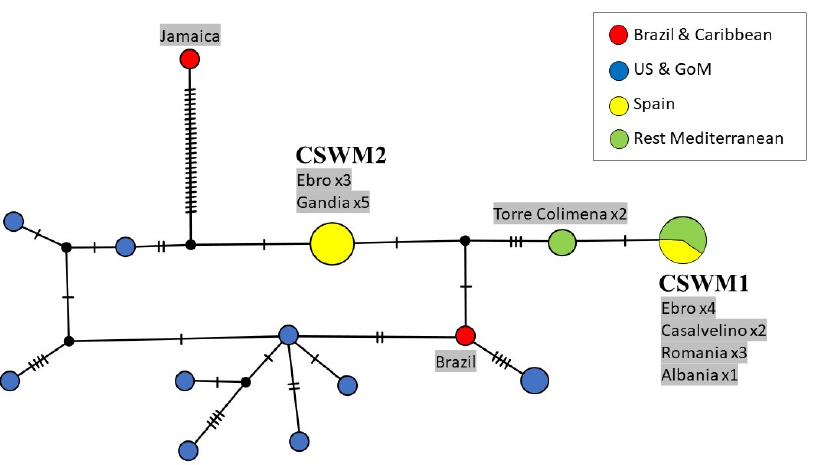
Figure 4. Maximum parsimony network showing genetic distances among 32 sequences of Callinectes sapidus combining the ‘Folmer region’ and beginning of the ‘Palumbi region’ of the COI gene (998 bp; 22 current study, 10 GenBank), constructed with TCS (Popart vers. 1.7). Diameters of the circles correspond to the frequencies of the respective haplotypes. The numbers of dashes display mutational steps (each dash stands for one single nucleotide mutation). Small black circles represent hypothetical (missing) haplotypes. Sample locations are represented by colors, with the North American lineage in blue, South American and Caribbean lineages in red, Spain in yellow, and the remaining Mediterranean Sea in green. Self-generated sequences are shown as grey fields. Abbreviations: GoM = Gulf of Mexico.